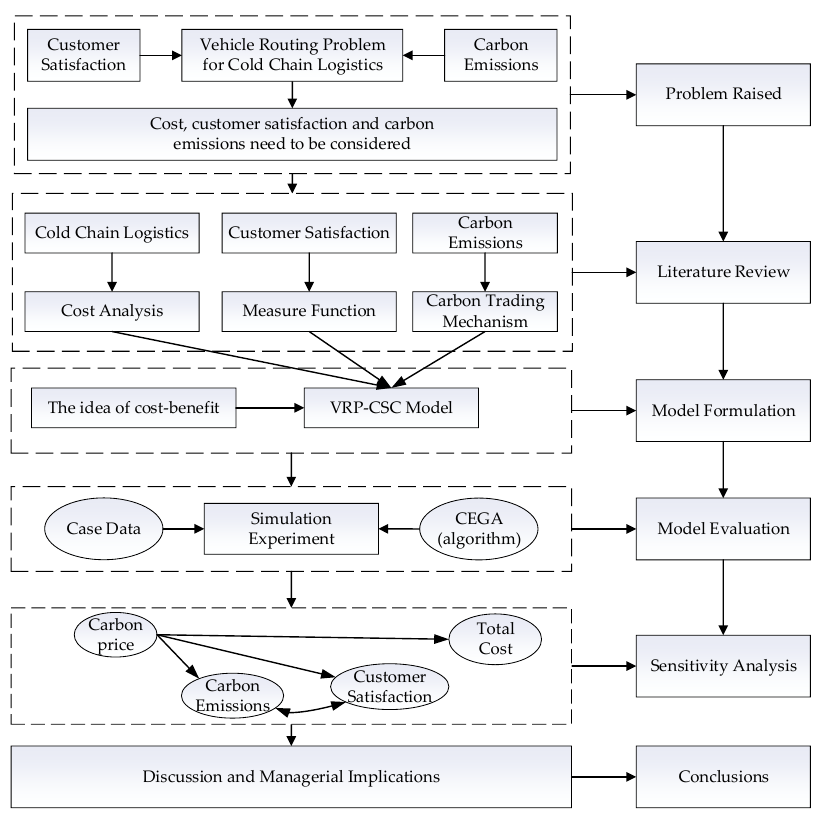
Figure 1. Flowchart of the study.